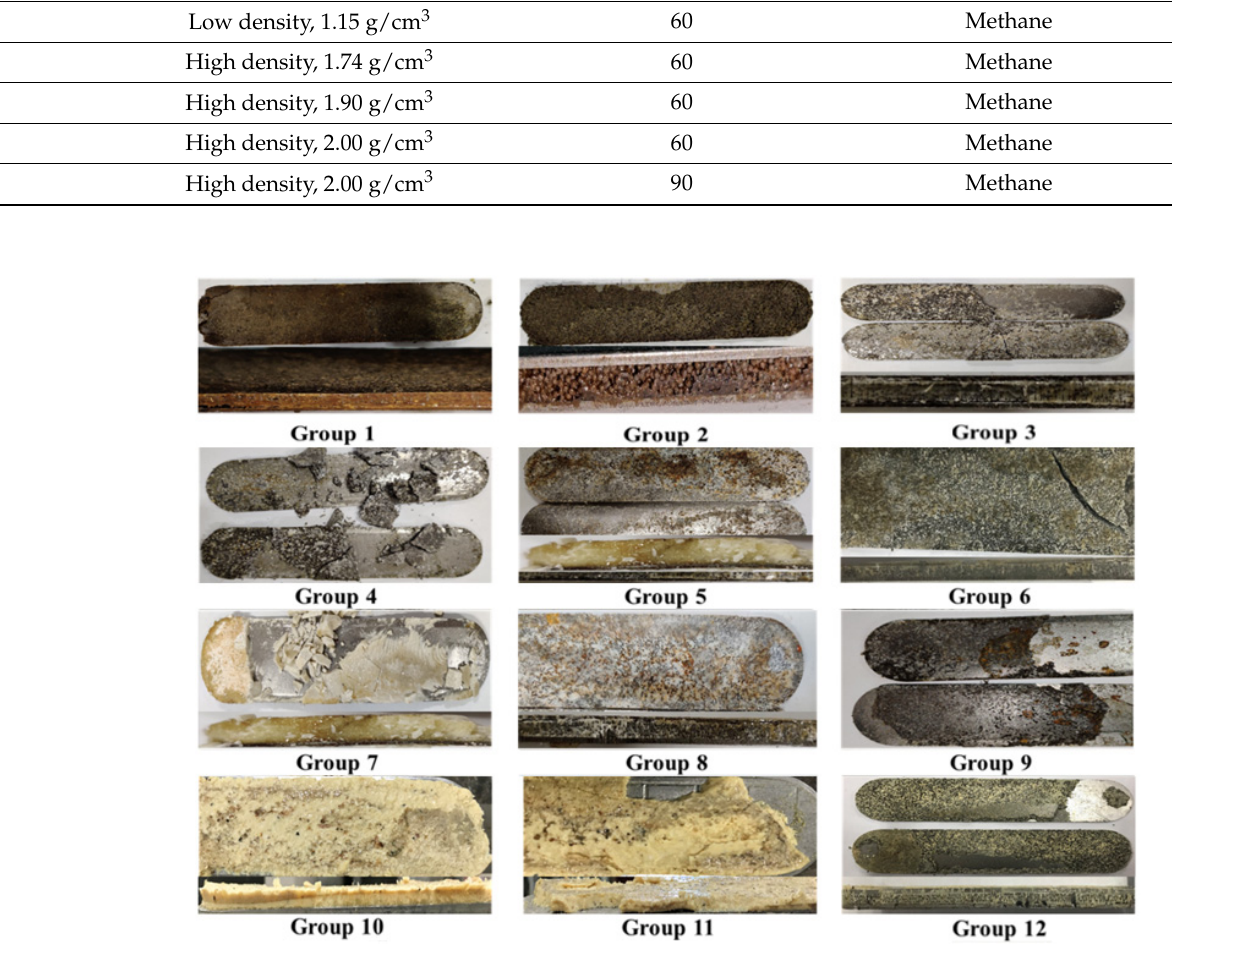
Figure 7. Optical photos of the plugging agent and the proppant after the test.